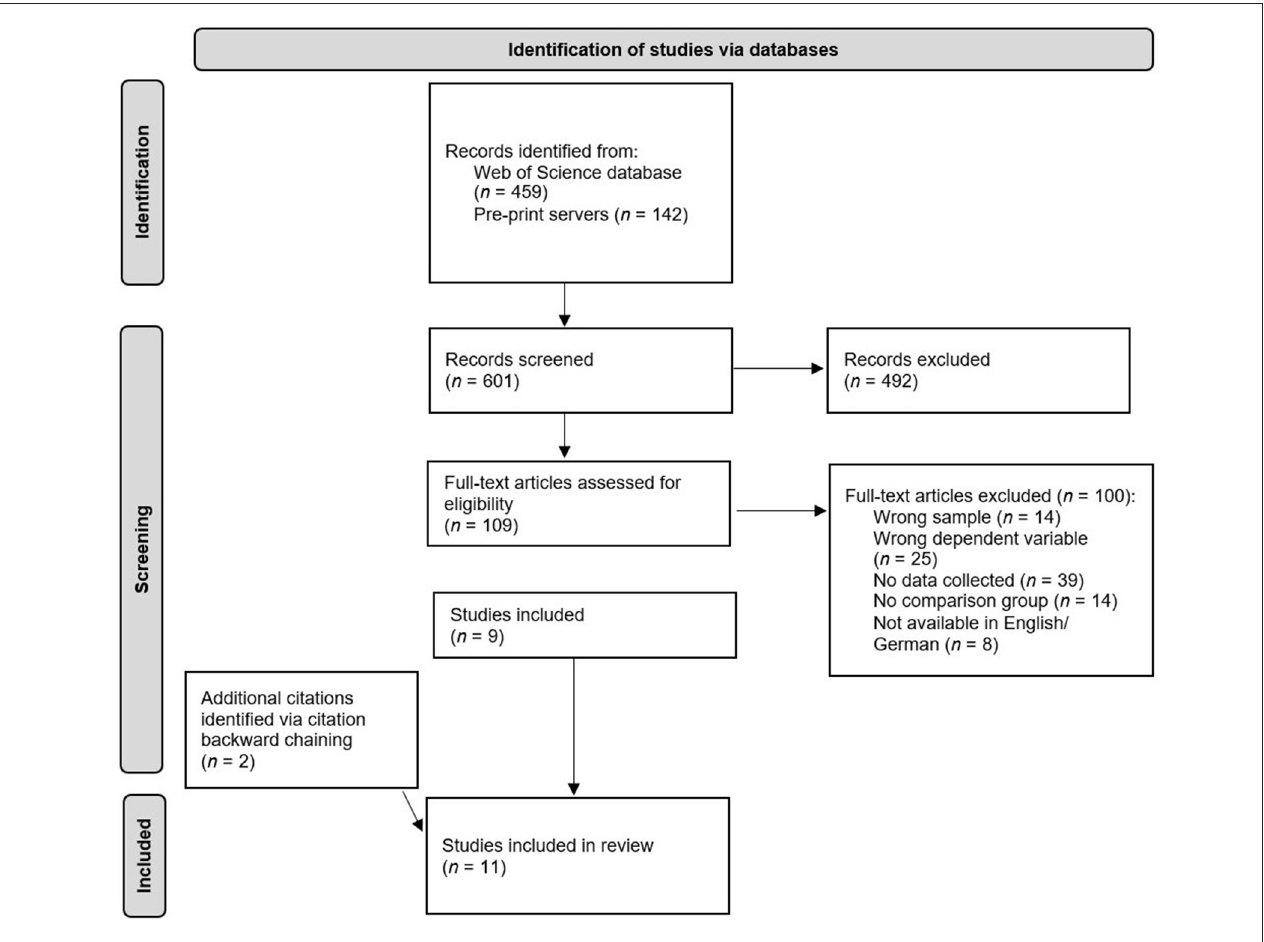
FIGURE 1 | PRISMA flowchart of the literature search and screening